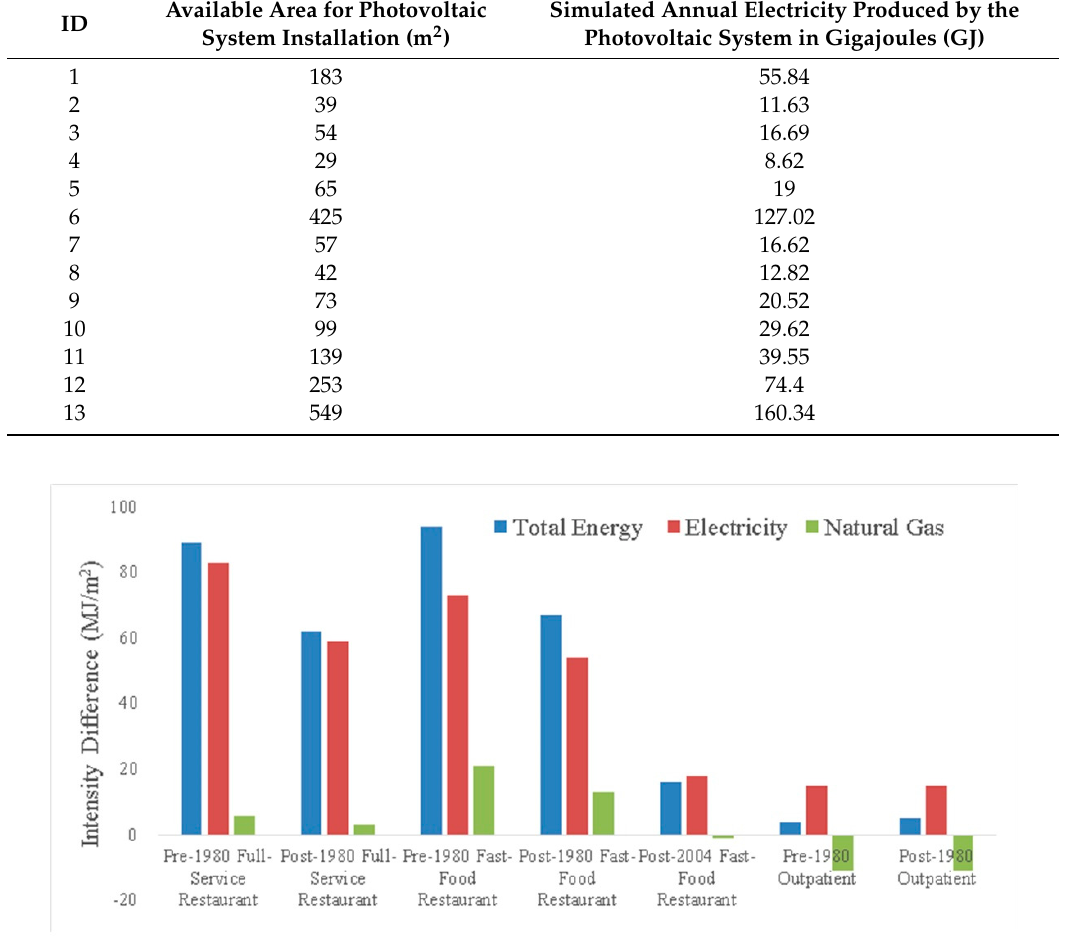
Table 3. Simulation of annual electricity produced by photovoltaic panels in 2050 for the tested buildings under the A1F1 emission scenario.